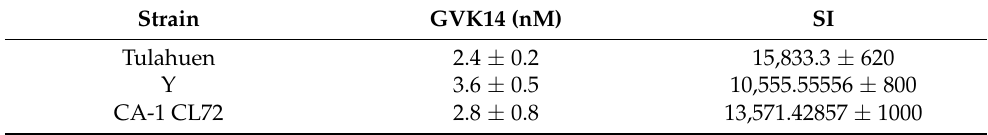
Table 1. EC 50 and selectivity index of GVK14 in infected myoblasts by strains of T. cruzi